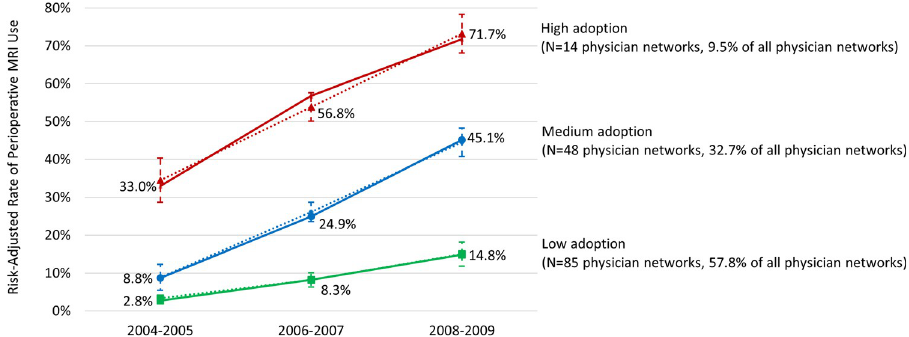
Fig 2. Distinct trajectories of adopting perioperative MRI among physician patient-sharing networks. MRI = magnetic resonance imaging. Rate of perioperative MRI use reflects risk-adjusted rate for each physician patient-sharing network in each time-period after accounting for differences in patient tumor characteristics and other clinical risk factors. Solid lines reflect mean risk-adjusted rate among physician patient-sharing networks in each trajectory. Dotted lines reflect trajectories predicted by the growth mixture model, with error bars reflecting 95% confidence intervals.